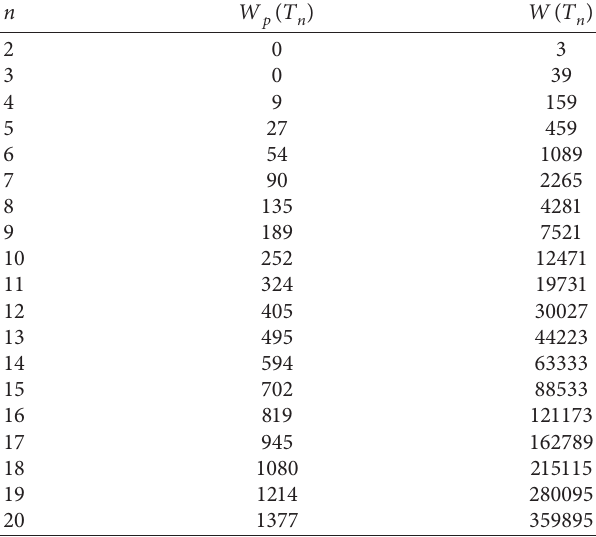
Table 2: Comparison of Wiener and Wiener polarity indices of ET n .